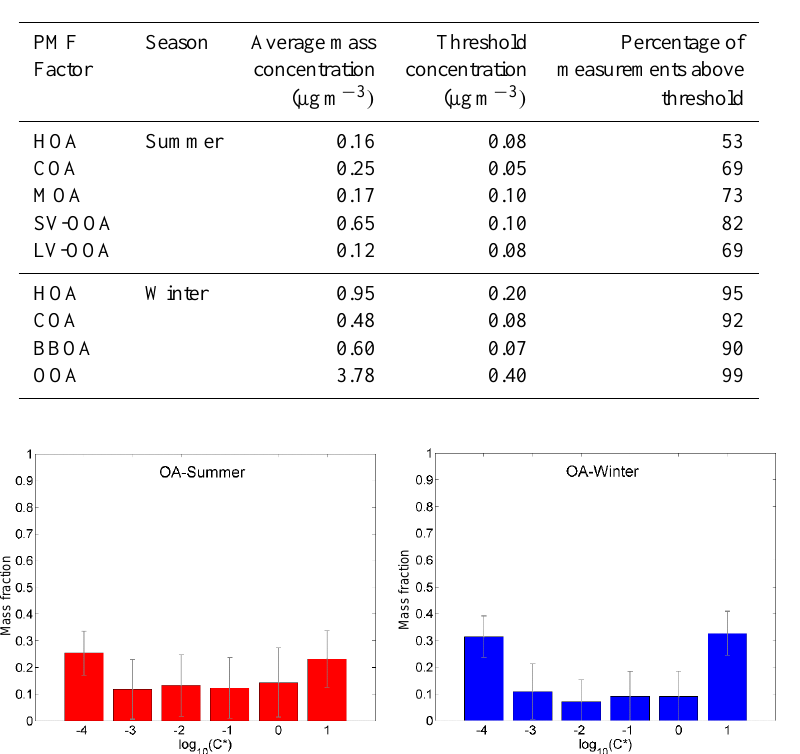
Table 1. Average and threshold ambient concentrations for each PMF factor.